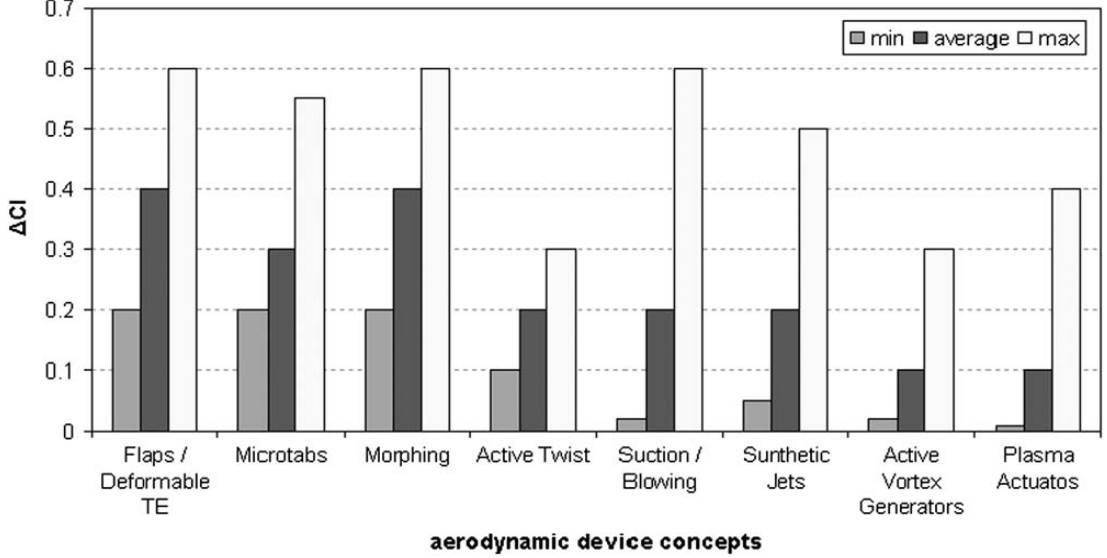
Figure 7. Comparison of aerodynamic device concepts in terms of lift control capability